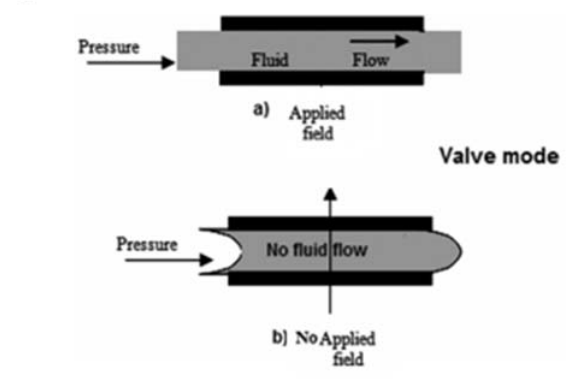
Fig. 3. Representation of the pressure mode of the NC MR fluid